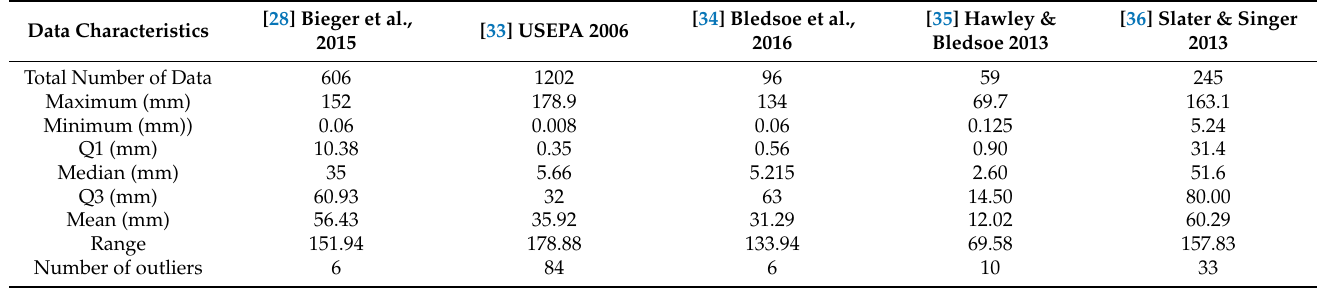
Table 2. Descriptive Statistics for the D50 data obtained from the five sources.